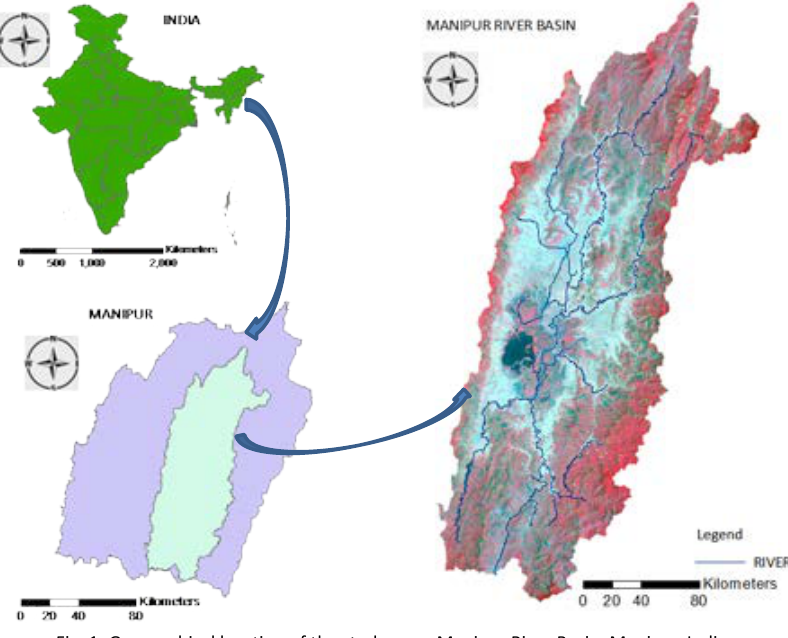
Fig. 1: Geographical location of the study area, Manipur River Basin, Manipur, India